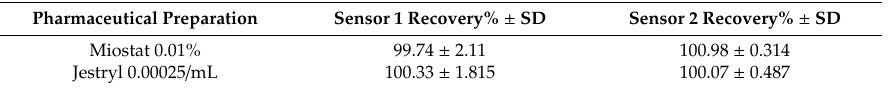
Table 4. Application of proposed sensors in Miostat and Jestryl ophthalmic solutions.